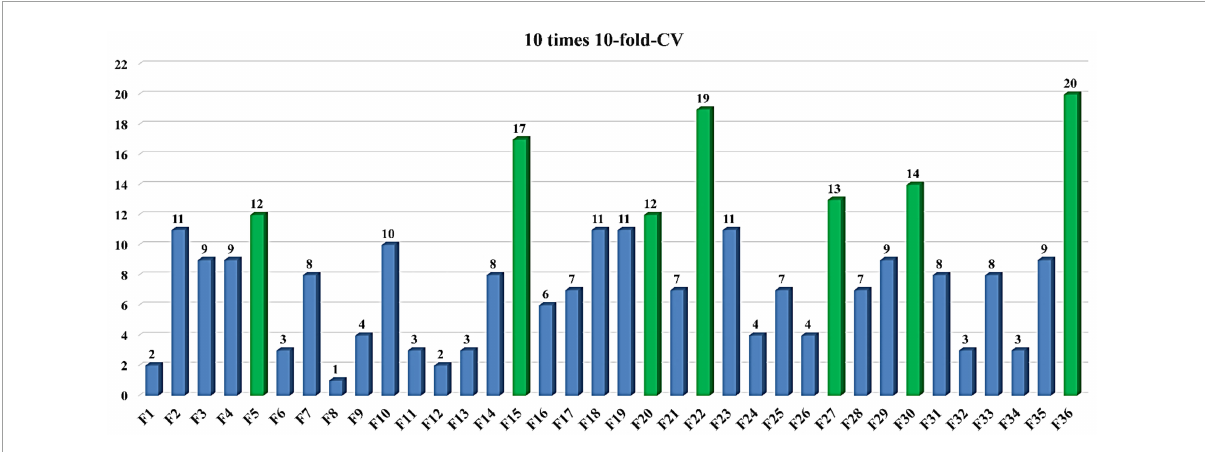
FIGURE20 The results of 10 times 10-fold crossover